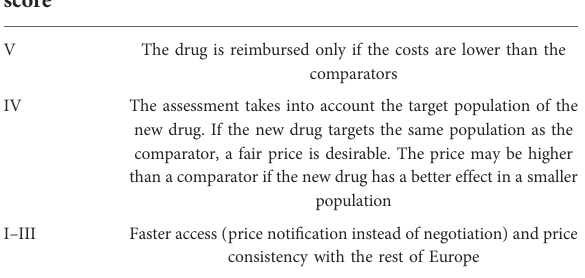
TABLE 3 Price level corresponding to the ASMR score assigned to the medicinal product under consideration. ASMR score